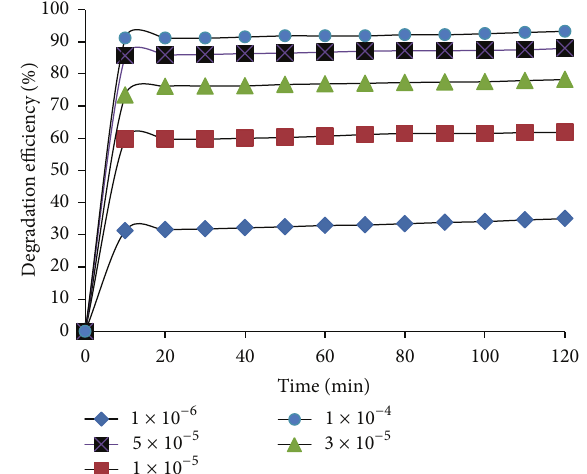
Figure 5: Effect of MAG concentration on the discoloration effi- ciency for Fenton-like oxidation process.